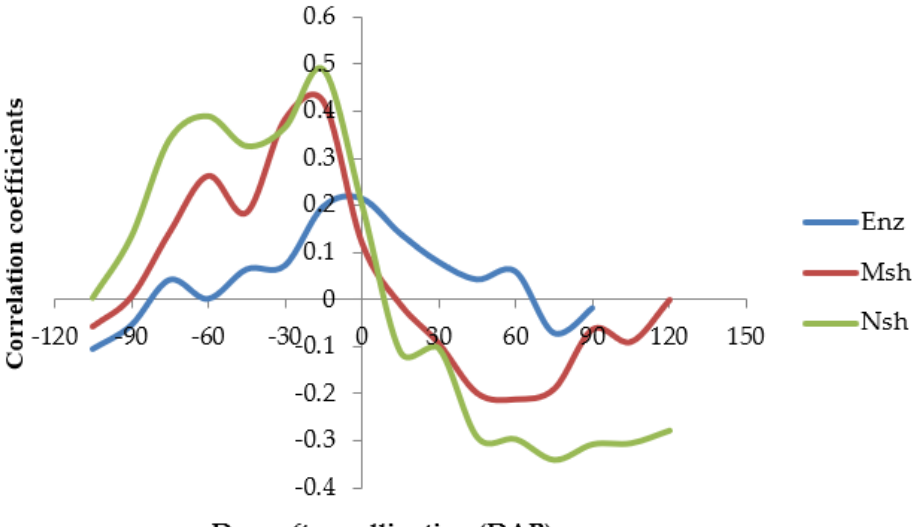
Figure 2. A graph of correlation coefficients between average temperature at 2 m height and seed set per 100 fruits per bunch at various bunch development stages of ‘Enzirabahima’ (Enz), ‘Mshale’ (Msh) and ‘Nshonowa’ (Nsh) after pollination with ‘Calcutta 4 ′ between January 2016 and January 2019.